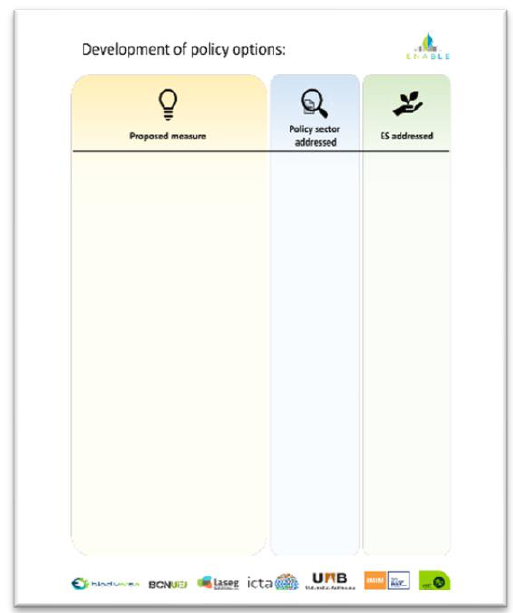
Fig. 6.2 Policy options poster development